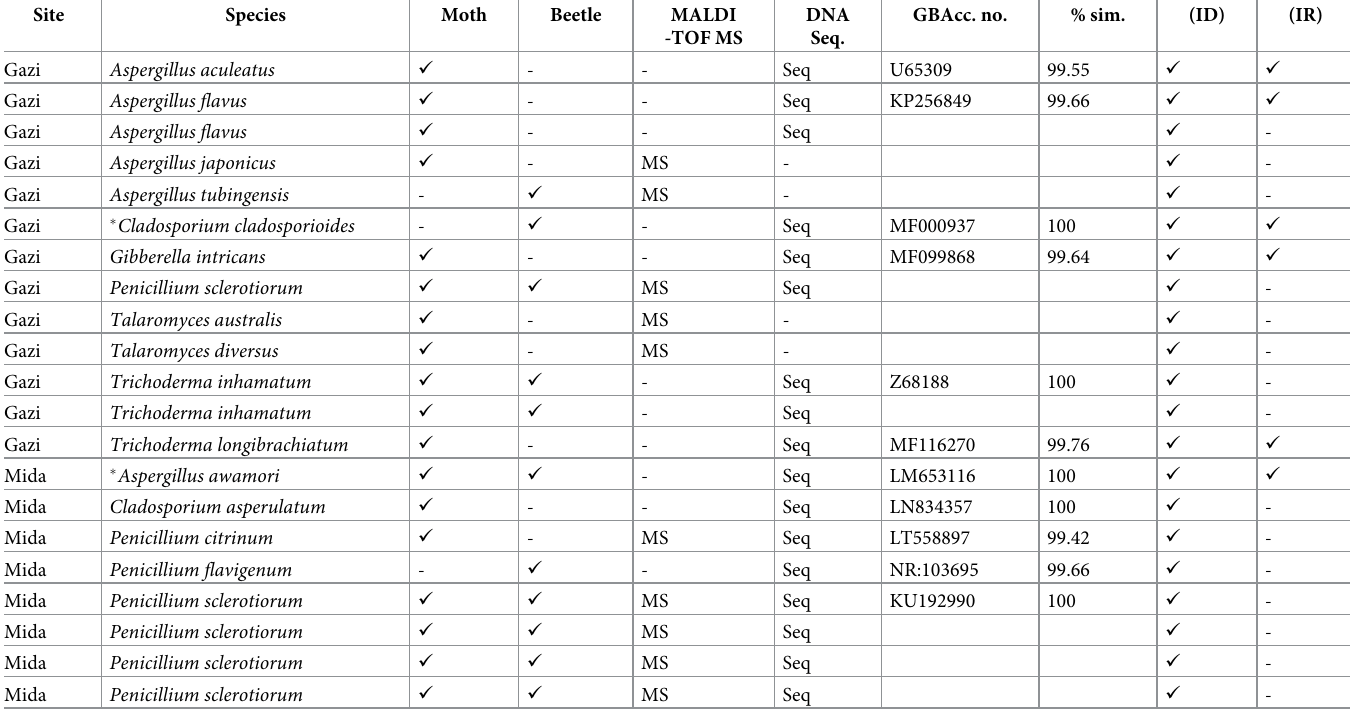
Table 3. Summary of the fungal species found in the branches of infested S . alba trees in Gazi Bay and Mida Creek.